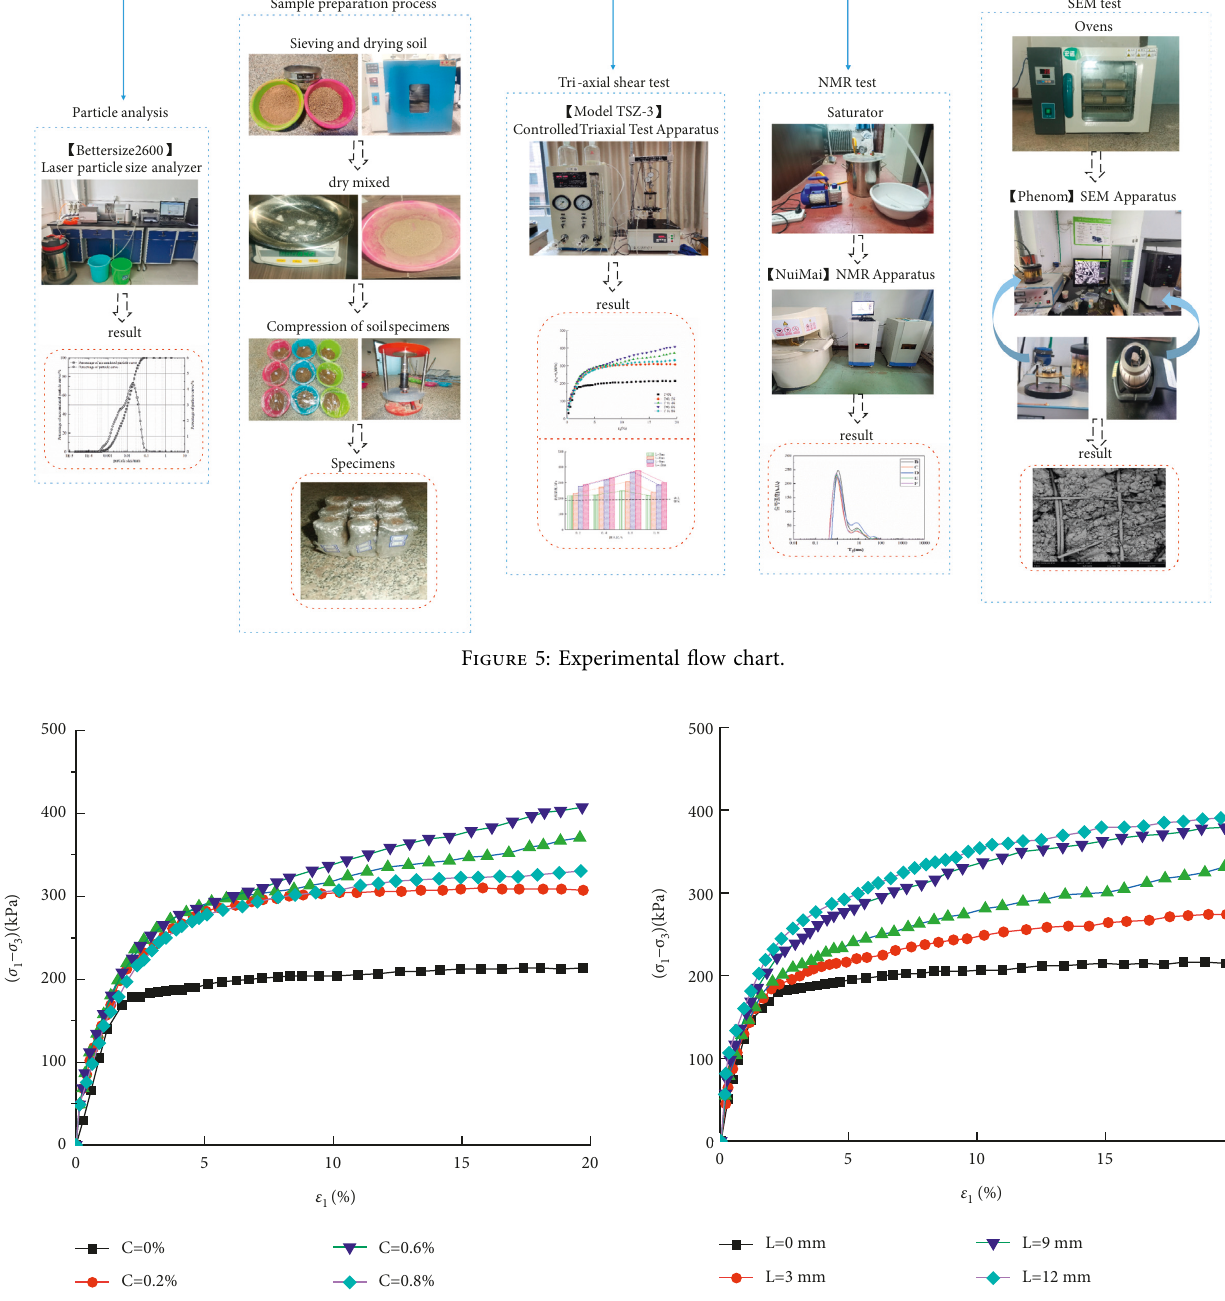
Figure 6: Relationship between stress–strain curves for different glass fiber contents.